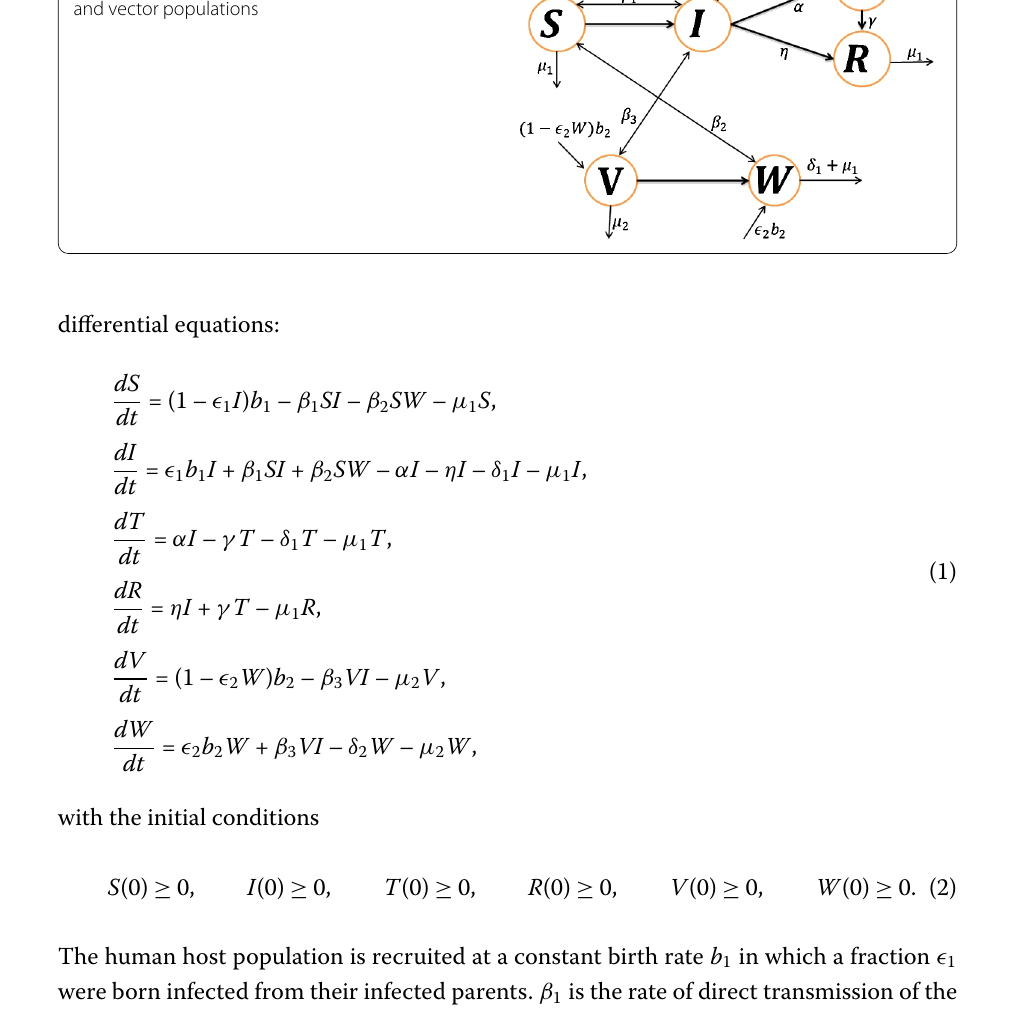
Figure 1 The flow chart represents the interactions and transfer of a vector-borne disease in both human and vector